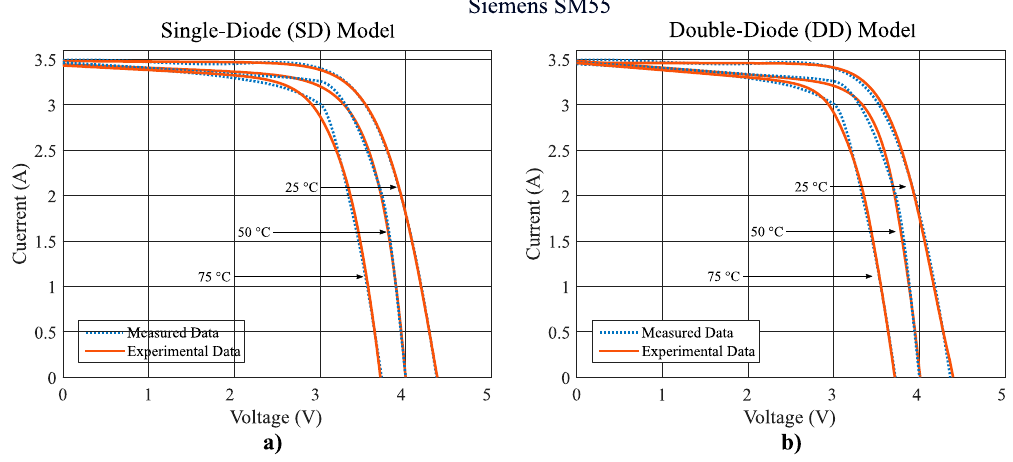
Figure 11. Estimated I-V characteristics curves at different cell temperatures (25, 50 and 75 ◦ C) and fixed solar irradiance ( G = 1000 W/m 2 ) for an individual cell from a Kyocera KC200GT Solar Panel. ( a ) SD model and ( b ) DD model. Table 8. SD model PV cell parameters at different cell temperatures (25, 50 and 75 ◦ C ) and fixed solar irradiance ( G = 1000 W/m 2 ), extracted by considering an individual PV cell from both the Kyocera KC200GT and Siemens SM55 Solar Panels.